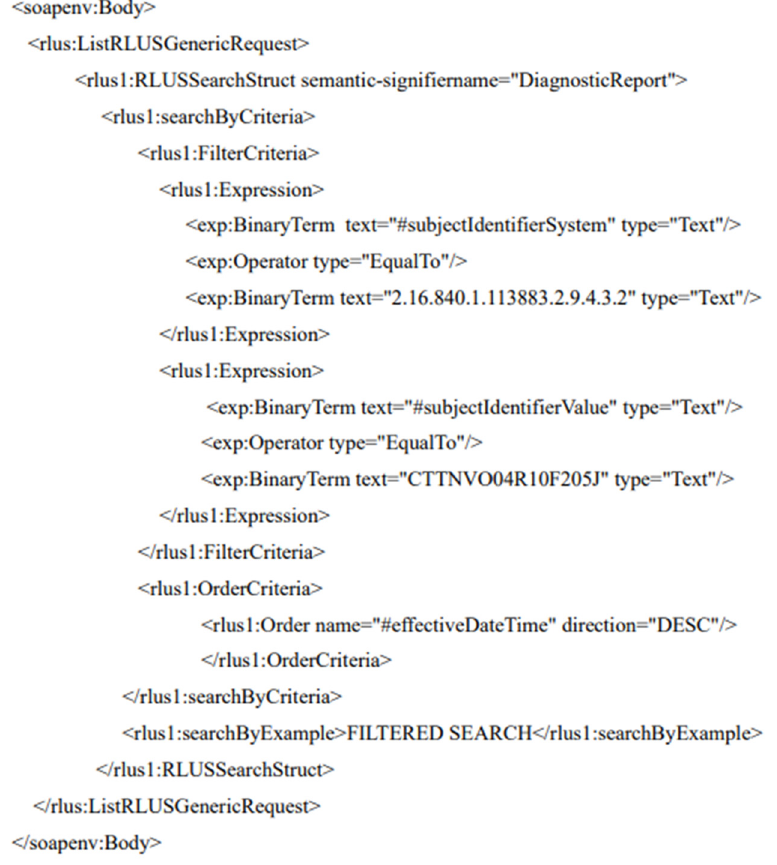
Figure 8. RLUS message for the transfer of the FC.